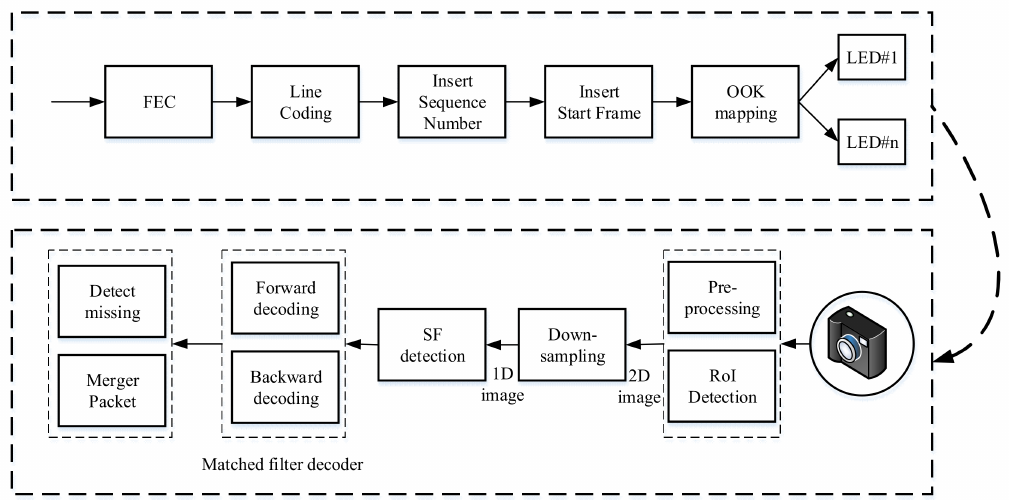
Figure 1. Reference architecture of the multiple-input multiple-output–camera on–o ff keying (MIMO–COOK)